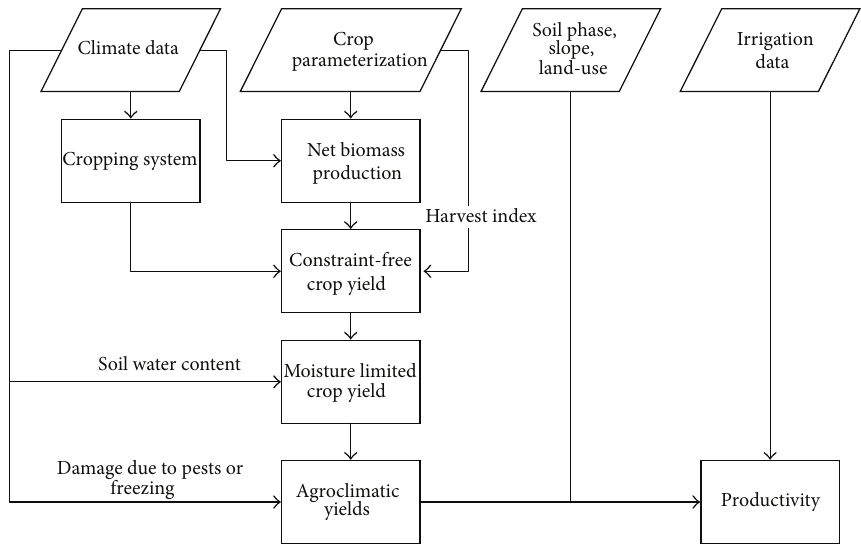
Figure 1: Flowchart for calculating potential productivity using the GAEZ